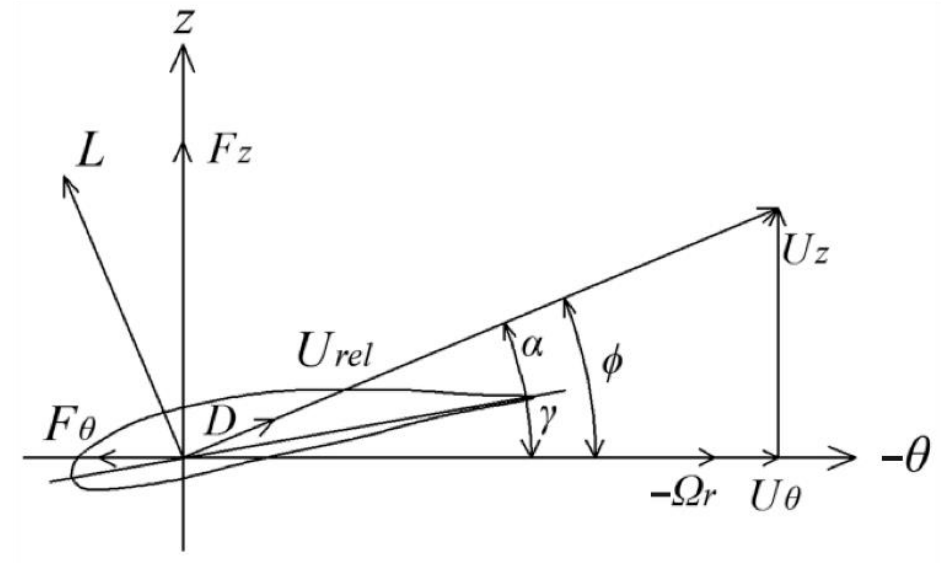
Figure 3. Velocity vectors of two-dimensional airfoil section [34].